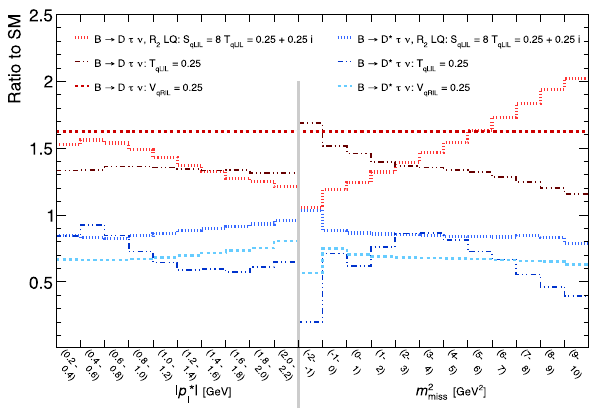
Fig. 1 The ratios of differential distributions with respect to the SM, as functions of | p ∗ (cid:8) | and m 2 , for various Wilson coefficient working miss points. For more details see text